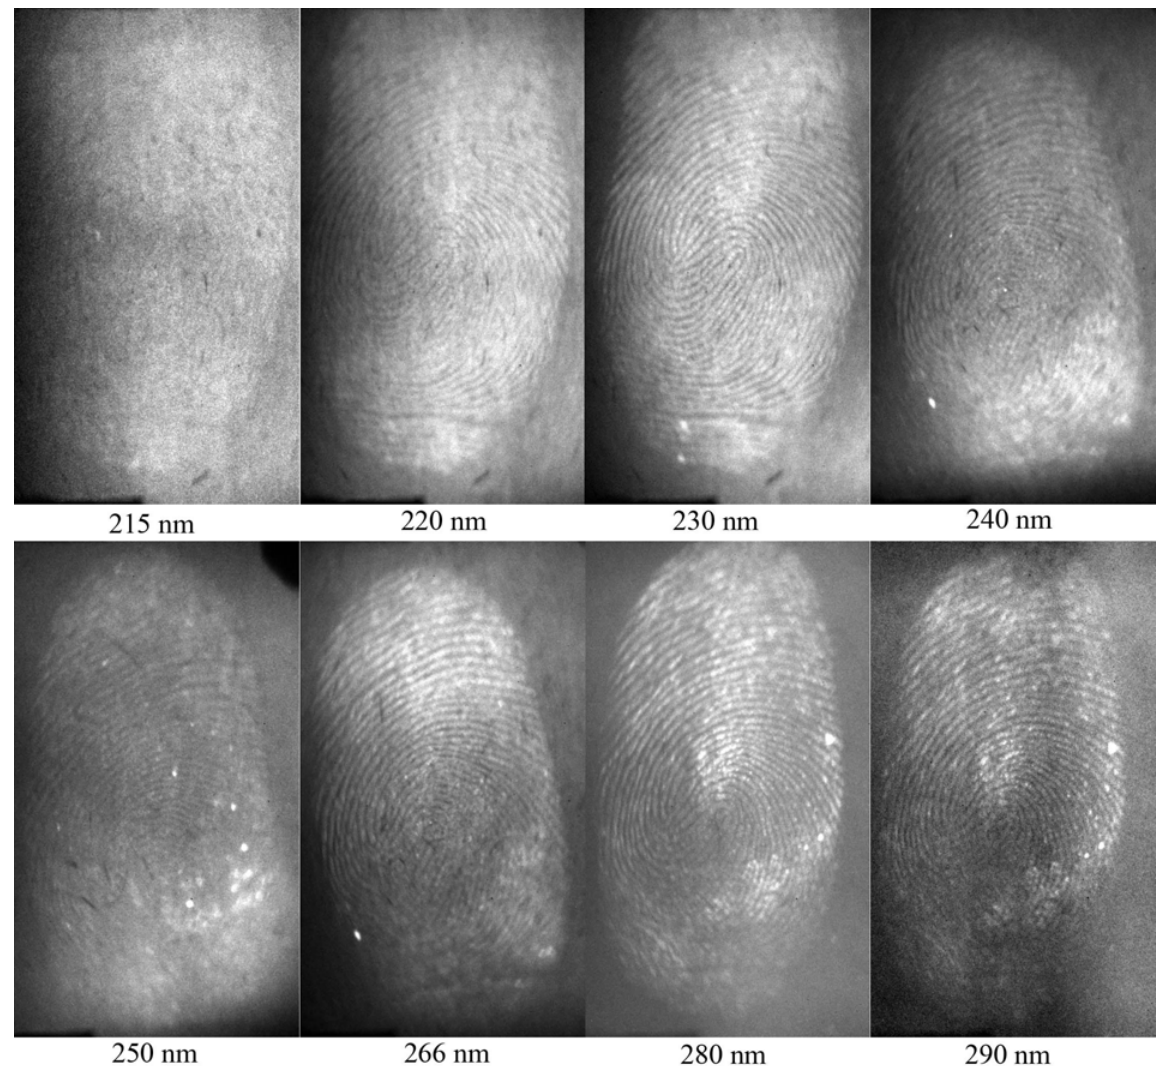
FIGURE 5. Fluorescence images of latent fingerprints on a HG white paper excited with various